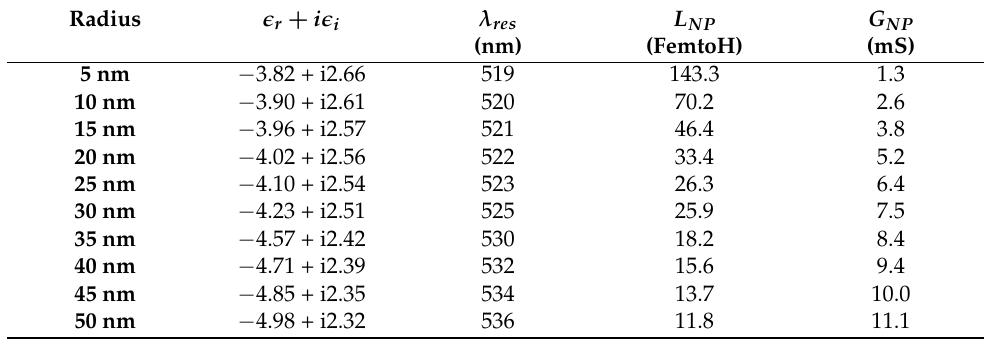
Figure 6. ( a ) The optical spectrum of Au nanospheres on tuning their radius from 5 nm to 50 nm in air as a surrounding medium. ( b ) The inductance and capacitance as a function of radius of Au NP evaluating using circuit theory (black squares) and Mie theory (blue diamond). Table 1. Effects of Au particles size on plasmonic resonance, nano-inductance and G NP